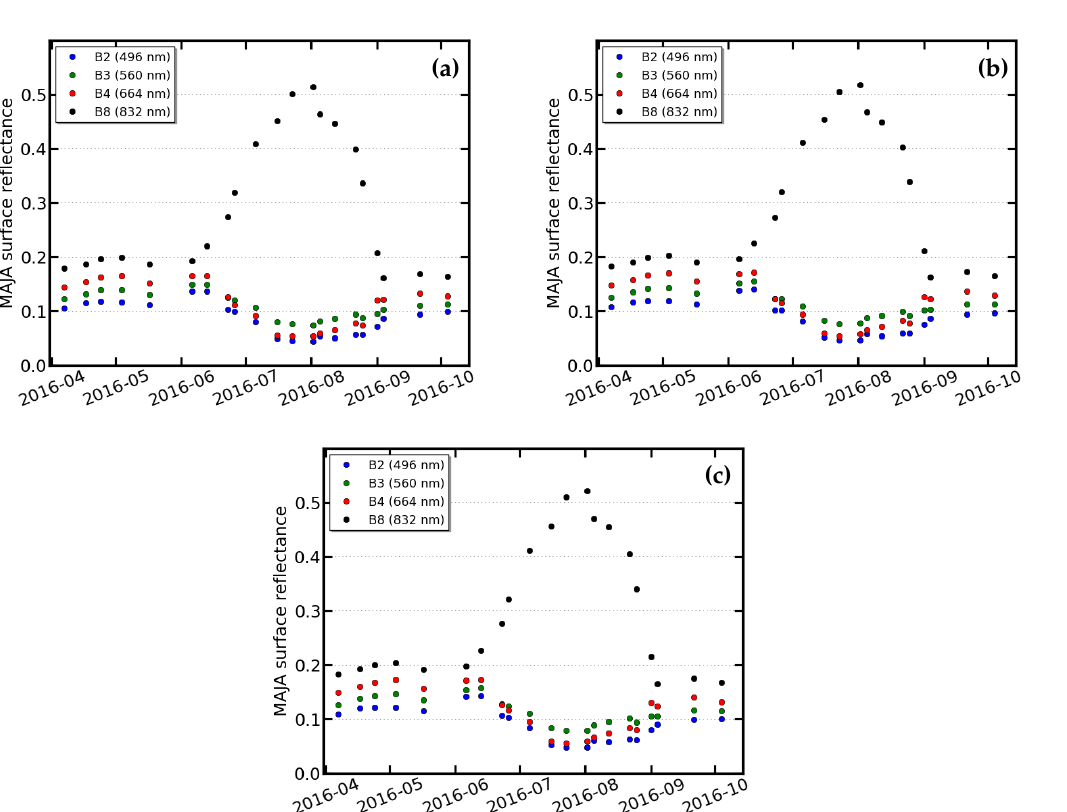
Figure 7. MAJA (MACCS-ATCOR Joint Algorithm) surface reflectance time series over a summer crop pixel from the Carpentras site: ( a ) with a constant aerosol type; ( b ) with four CAMS (Copernicus Atmosphere Monitoring Service) aerosol types; and ( c ) with five CAMS aerosol